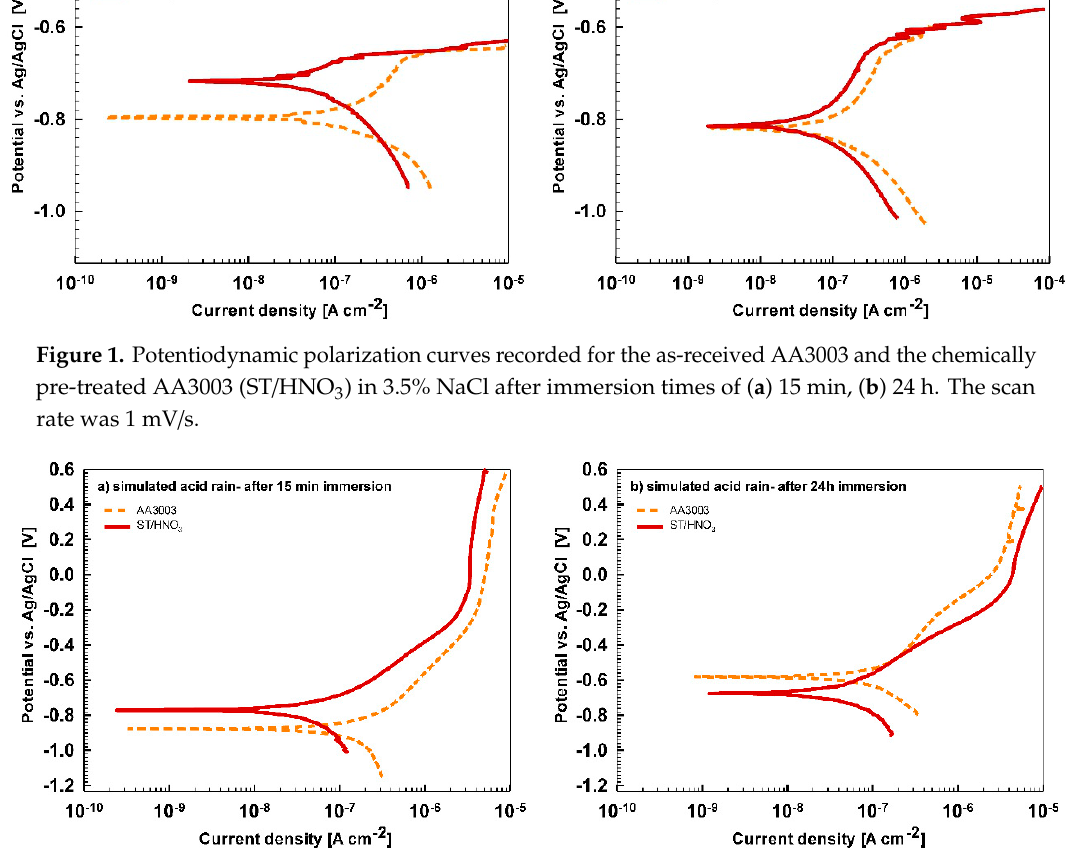
Figure 2. Potentiodynamic polarization curves recorded for as-received (bare) AA3003 and chemically pre-treated AA3003 (ST / HNO 3 ) in simulated acid rain after immersion times of ( a ) 15 min, ( b ) 24 h. The scan rate was 1 mV / s. Table 1. Polarization resistance ( R p ), corrosion current density ( j corr ), corrosion potential ( E corr ) and breakdown potential ( E bd ) measured after di ff erent immersion times in 3.5% NaCl and simulated acid rain for the as-received AA3003 and the chemically pre-treated AA3003 (ST / HNO 3 ) (Figures 1 and 2). Values are given as mean ± standard deviation.